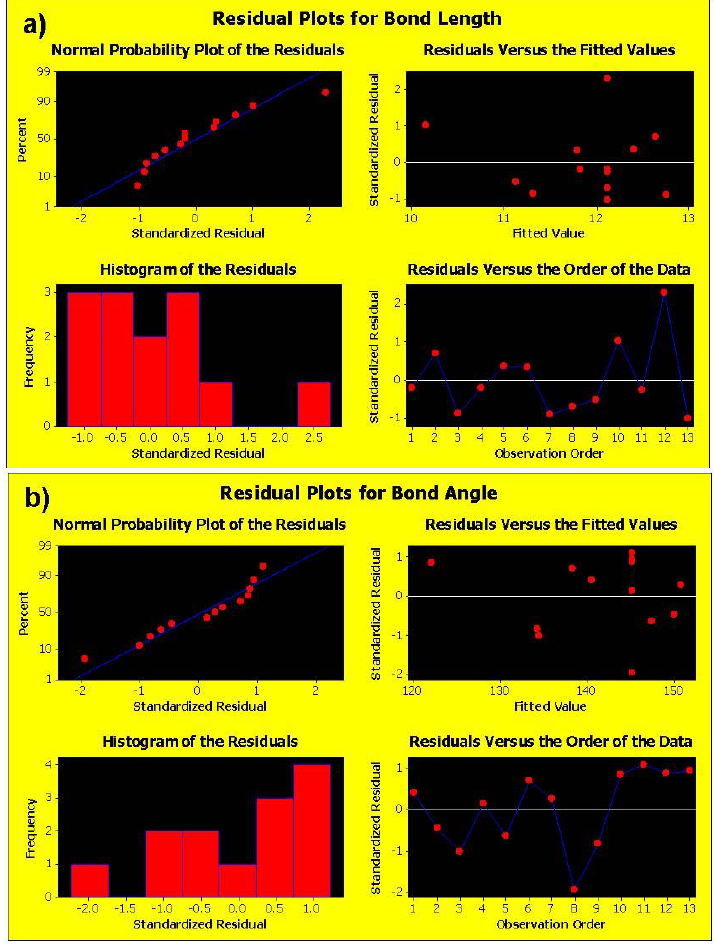
Curcumin:3 Glynornicotine) is also highlighted on the respective contour plots. Figure 10. Linear correlation plots depicting corresponding residual plots for various